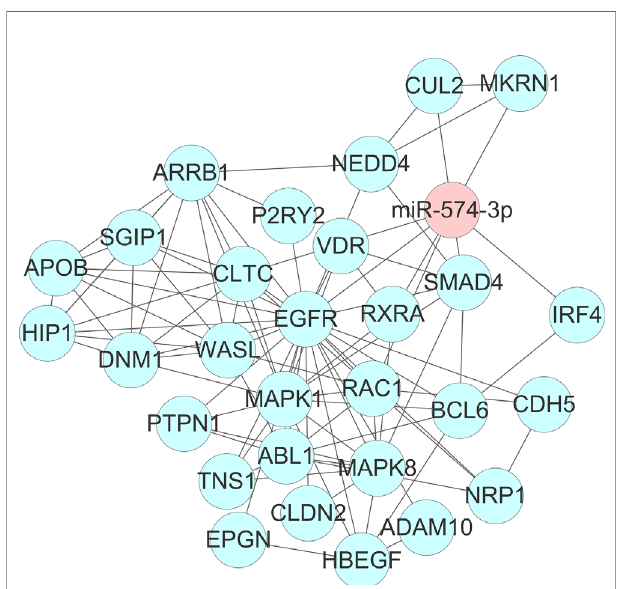
FIGURE 3 | Identi fi cation of an important regulatory role for miR-574-3p- mediated signaling pathways (especially the EGFR/RAC1 pathway) in spinal chordoma by integrated analysis of both the miRNA-mRNA and protein- protein interaction networks data. miRNA,